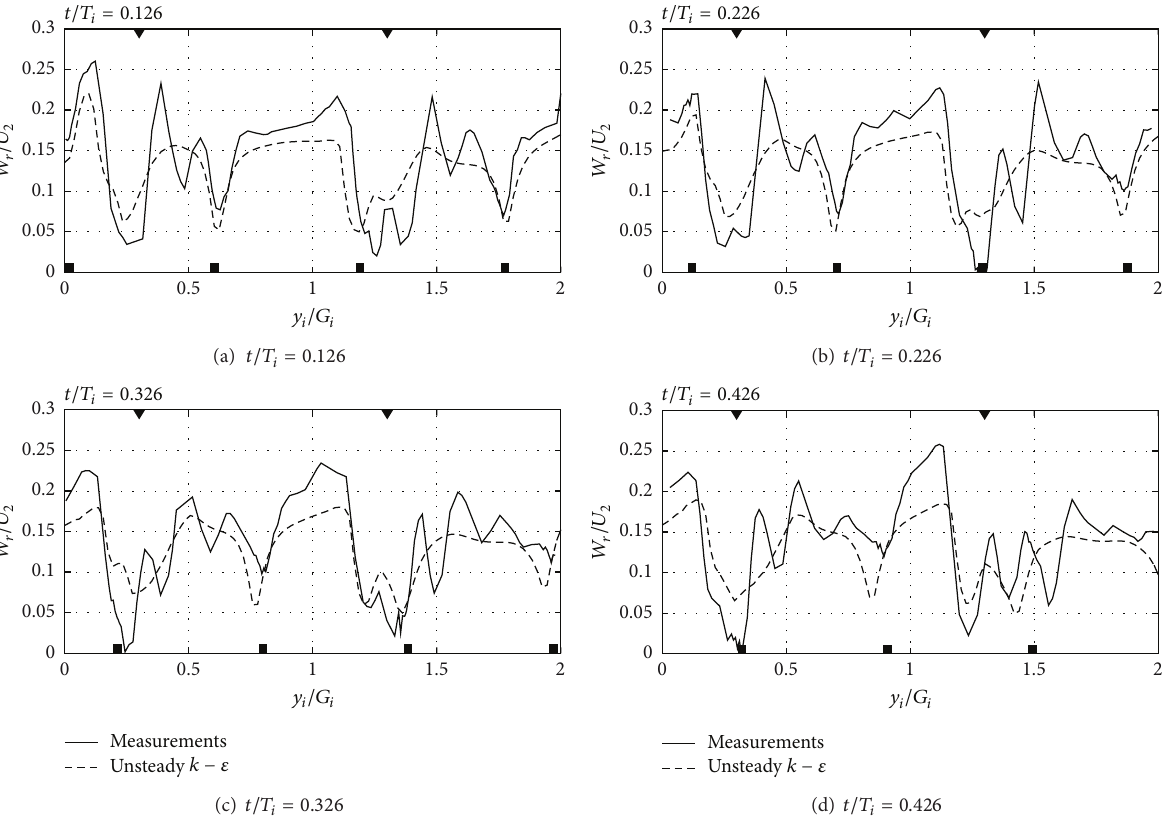
Figure 6: Radial velocity in the radial gap ( 𝑅/𝑅 2 = 1.02 ) at mid-span for the unsteady simulation using the 𝑘 − 𝜀 turbulence